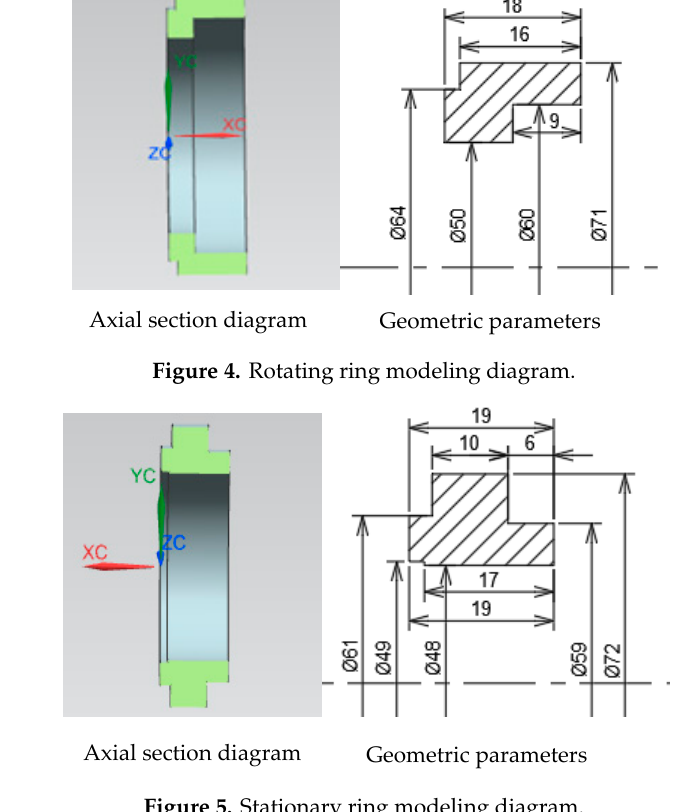
Figure 5. Stationary ring modeling diagram.